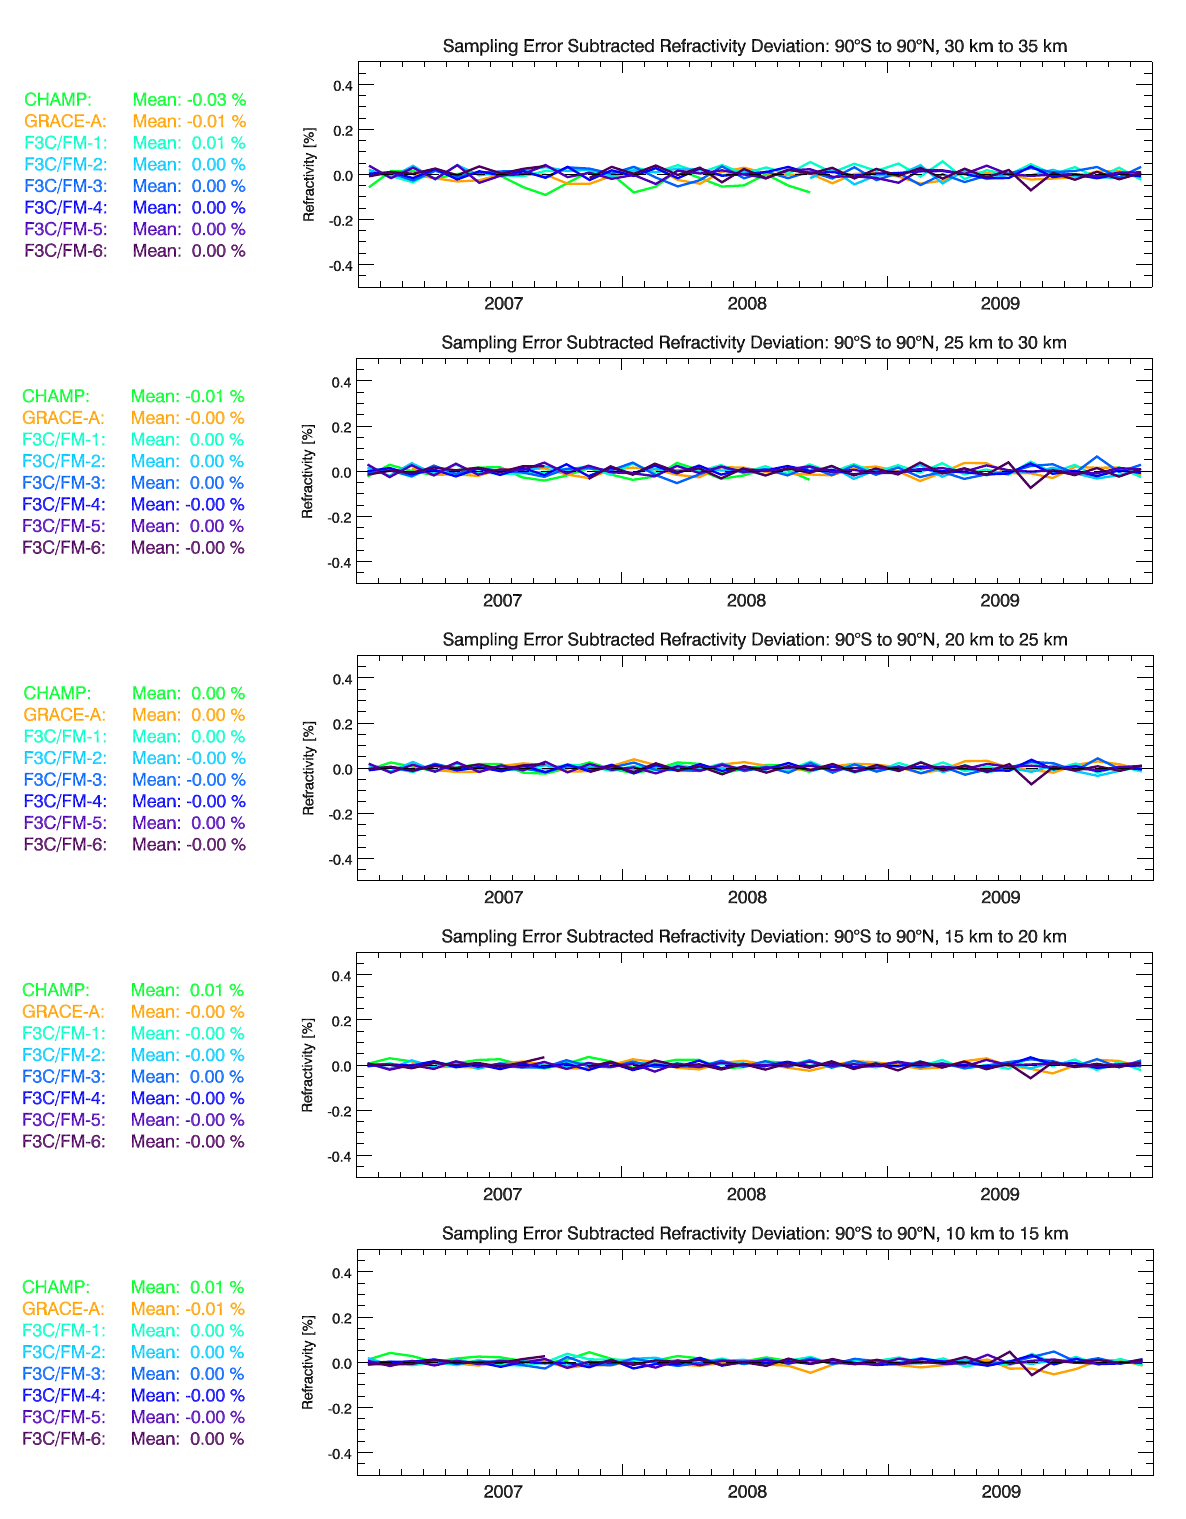
Fig. 5. Global mean monthly mean single-satellite refractivity deviations from the multi-satellite mean, after subtraction of the respective sampling errors, for five different altitude layers in the UTLS: 30km to 35km, 25km to 30km, 20km to 25km, 15km to 20km, and 10km to 15km (top to bottom; same layout per panel as in Fig.